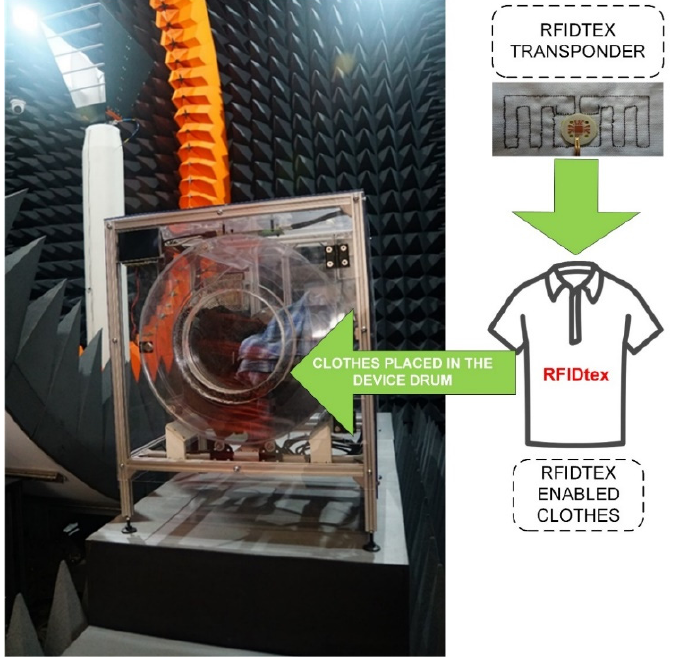
Figure 11. Developed device test stand.